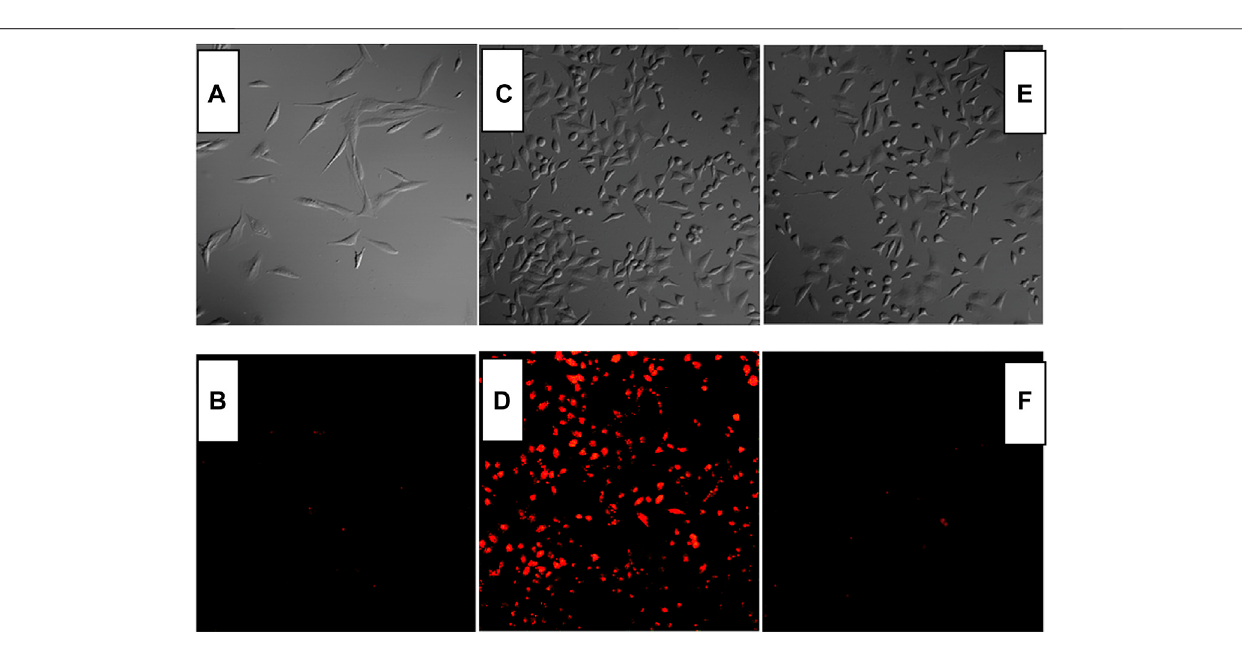
Frontiers in Chemistry |